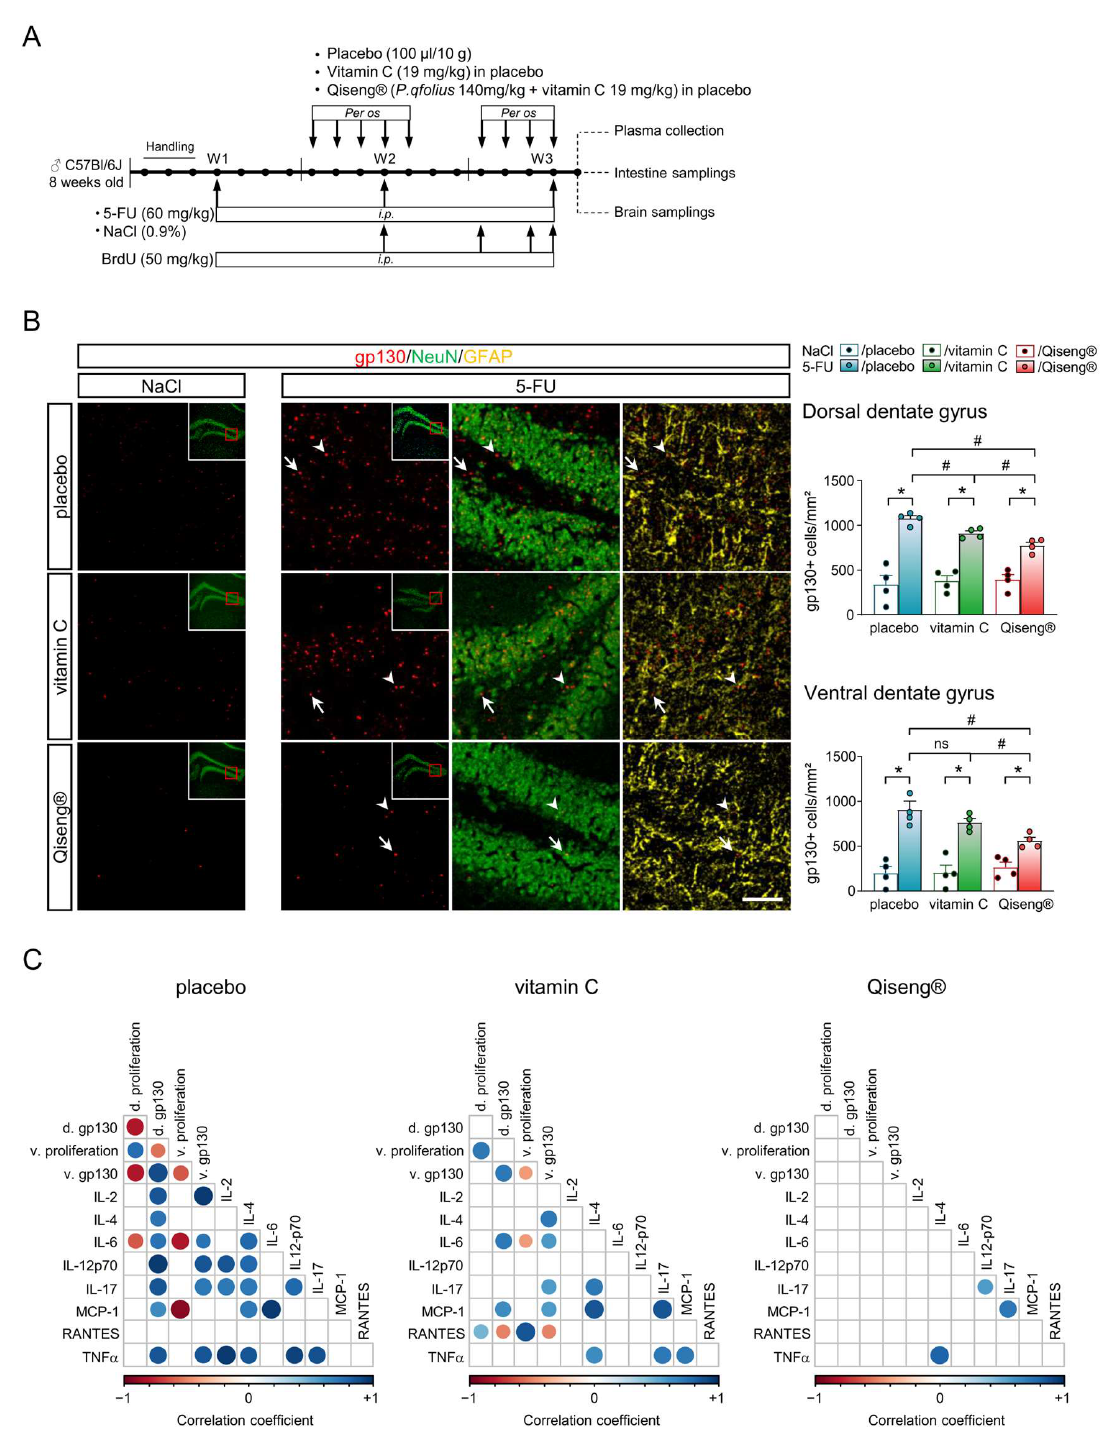
Figure 8. Effect of 5-FU chemotherapy treatment on brain Il-6 gp130 receptor in dorsal and ventral hippocampus. ( A ) Schematic timeline for treatments and plasma and brain sampling from the different groups of mice to investigate IL-6-related neuroinflammatory markers. ( B ) Representative microphotography of the IL-6 receptor gp130 (red) co-stained with the mature neuron NeuN (green) and astrocyte GFAP (yellow) markers in the dHp. The boxed areas show a magnification of gp130/GFAP main co-labelings (white arrows) in the dentate gyrus of the dHp. Scale bar: 100 µm. Bar plots represent mean ± SEM with symbols of individual data points of the effects of 5-FU in the presence of placebo, vitamin C and Qiseng ® compared with NaCl on gp130 positive cells in the dHp and vHp compared with their respective controls. Star indicates significant difference within the same groups, and hash indicates significant difference among 5-FU groups (Kruskal–Wallis-Dunn post hoc; * or # p < 0.05, ns: not significant). ( C ) Correlation between neural stem cell proliferation,